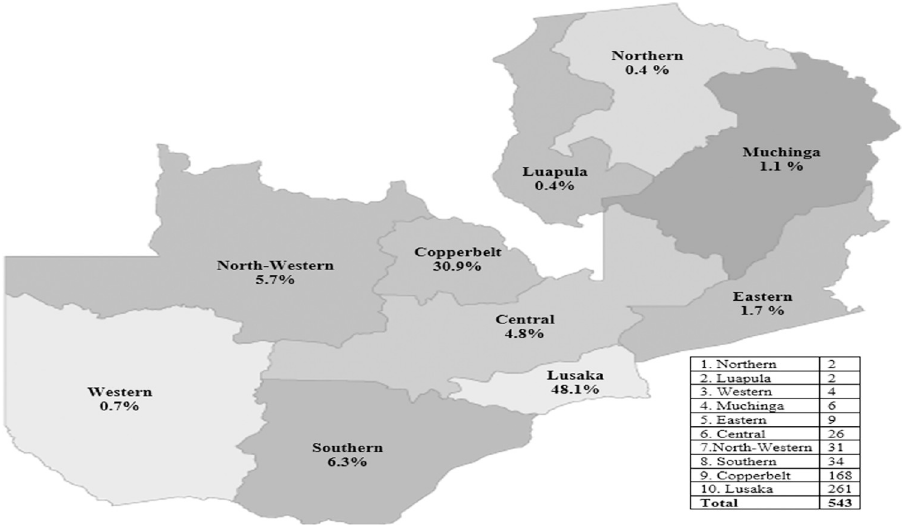
Fig 1. Distribution of accredited private health facilities segregated by provinces in Zambia for the year 2019 [24].